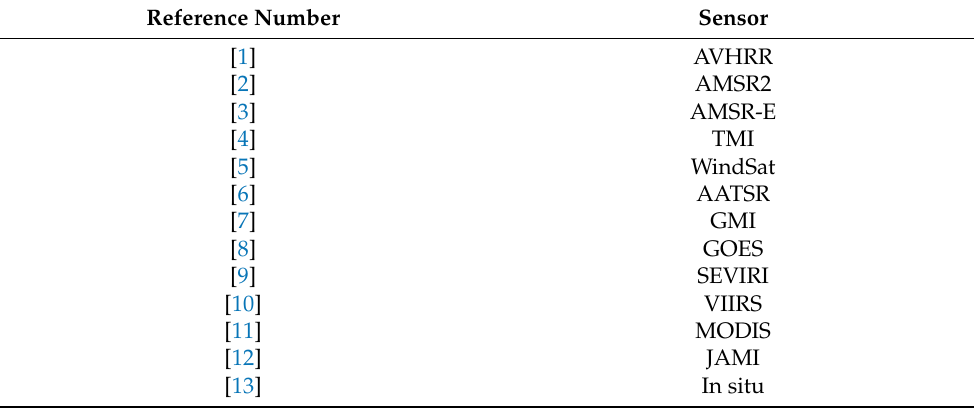
Table A1. Description of the sensors used to construct the L4 SST